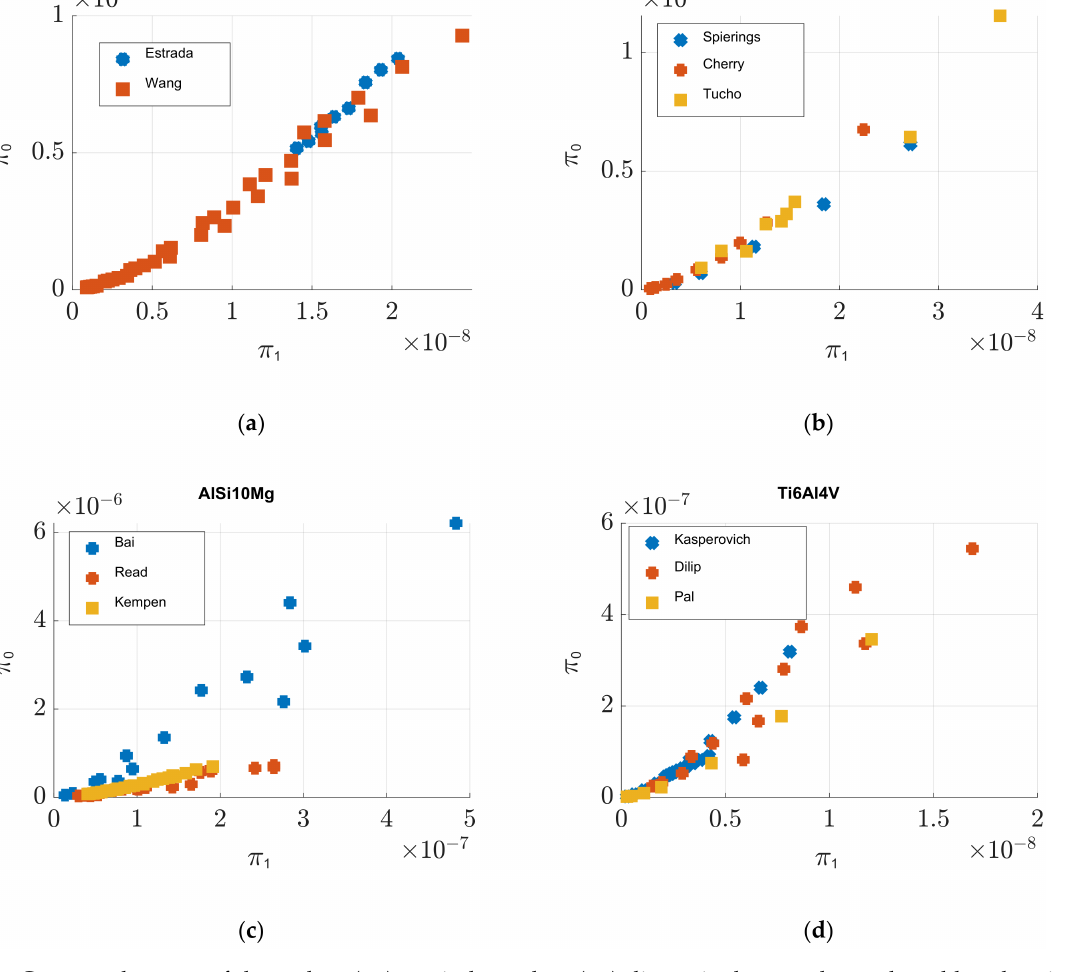
Figure 3. Computed curves of dependent ( π 0 ) vs. independent ( π 1 ) dimensionless products plotted by plugging the adapted experimental data, manufacturing conditions and relevant physical properties of each material contained in the following tables: ( a ) In718 with data from Tables A1 and A2, adapted from [13,16], ( b ) SS316L with data from Tables A7–A9, adapted from [21–23], ( c ) AlSi10Mg with data from Tables A3–A5, adapted from [17–19] and ( d ) Ti6Al4V with data